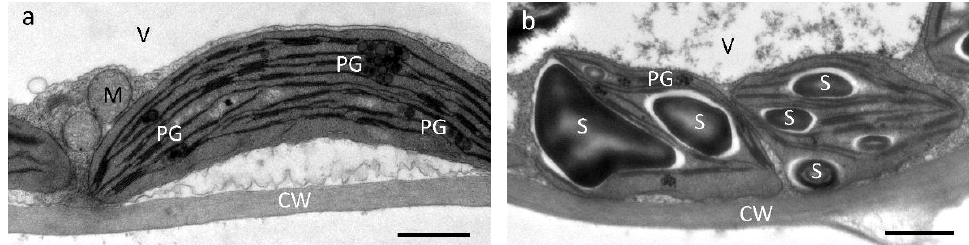
Figure 5. Ecotypic differences in chloroplast ultrastructure in mesophyll cells of Arabidopsis arenosa plants shown by transmission electron microscopy. Representative examples are shown for plants from ( a ) a foothill population and ( b ) an alpine population grown together in an alpine common garden. Letters indicate the cell wall (CW), plastoglobules (PG), mitochondrion (M), starch grain (S) and vacuole (V). Scale bars: 1 μm.